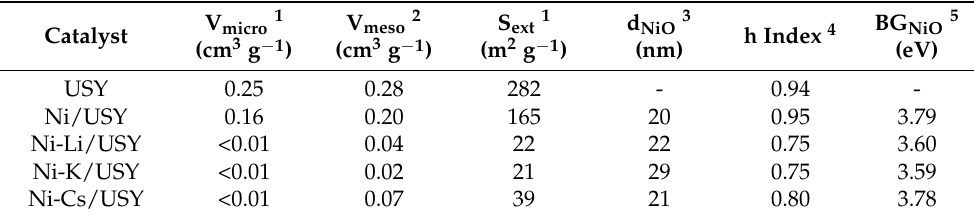
Table 1. Main properties obtained for the Ni-A/USY catalysts, Ni/USY reference sample and USY support after